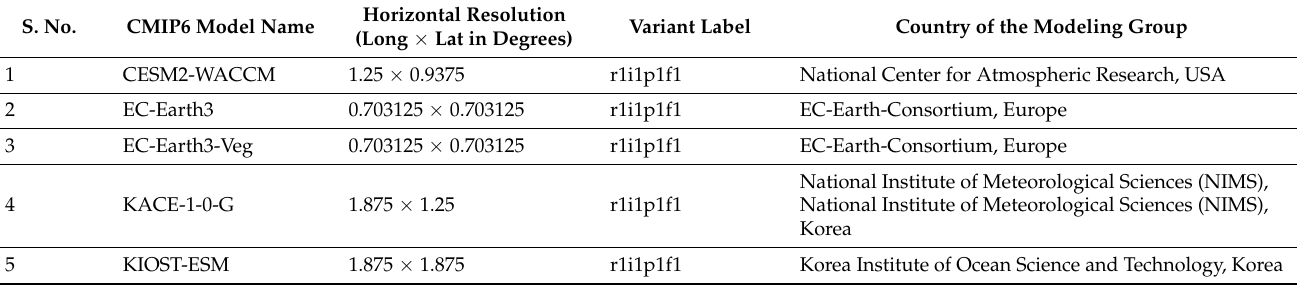
Table 1. List of CMIP6 models, resolution, variant, and country